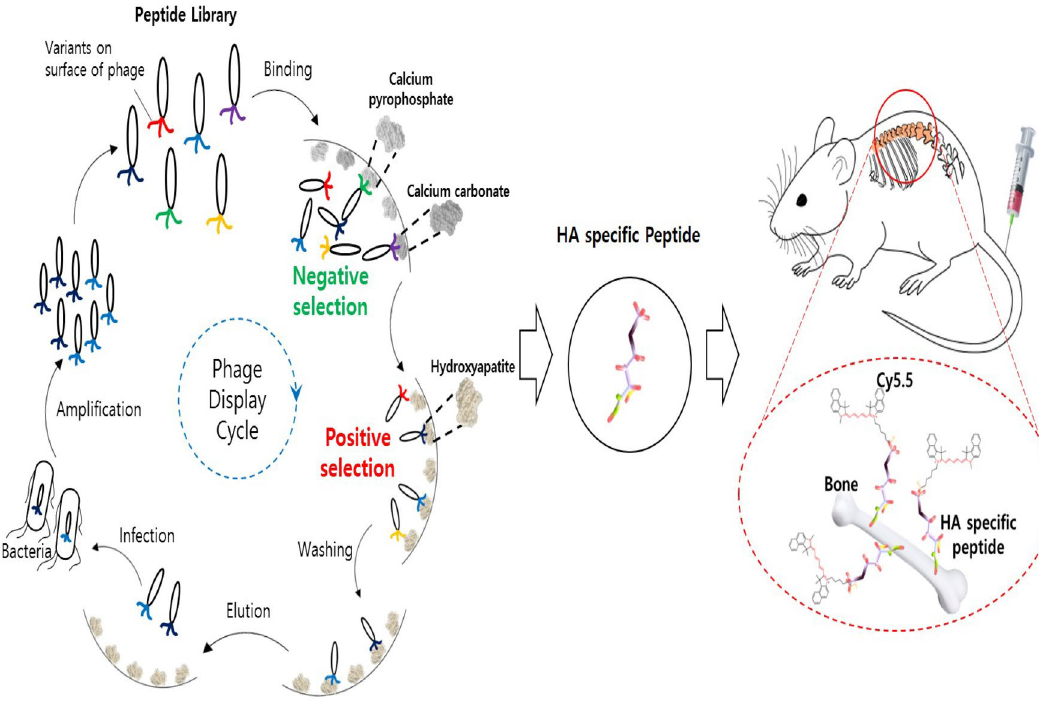
Figure 1. Overview of the screening of hydroxyapatite specific peptides and in vivo bone-targeting